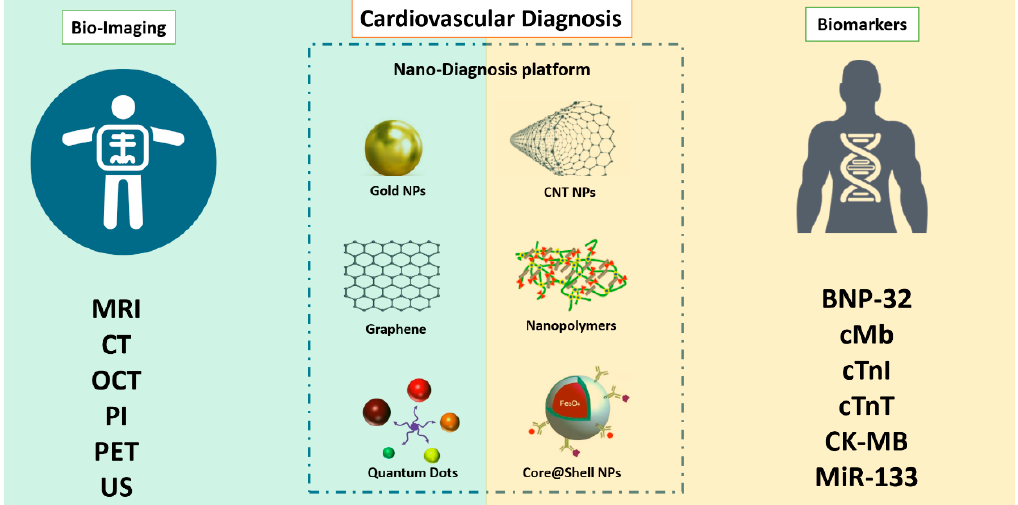
Figure 3. Diagnosis methods for CVDs.